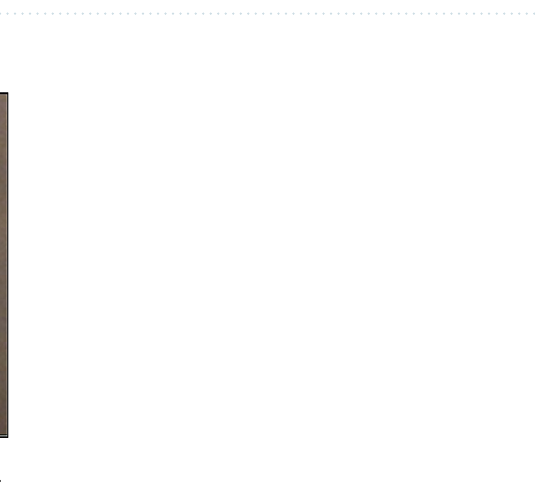
Table 3. Comparison of Ni particle properties, sheet resistance and substrate type between the present work and other reported Ni films.